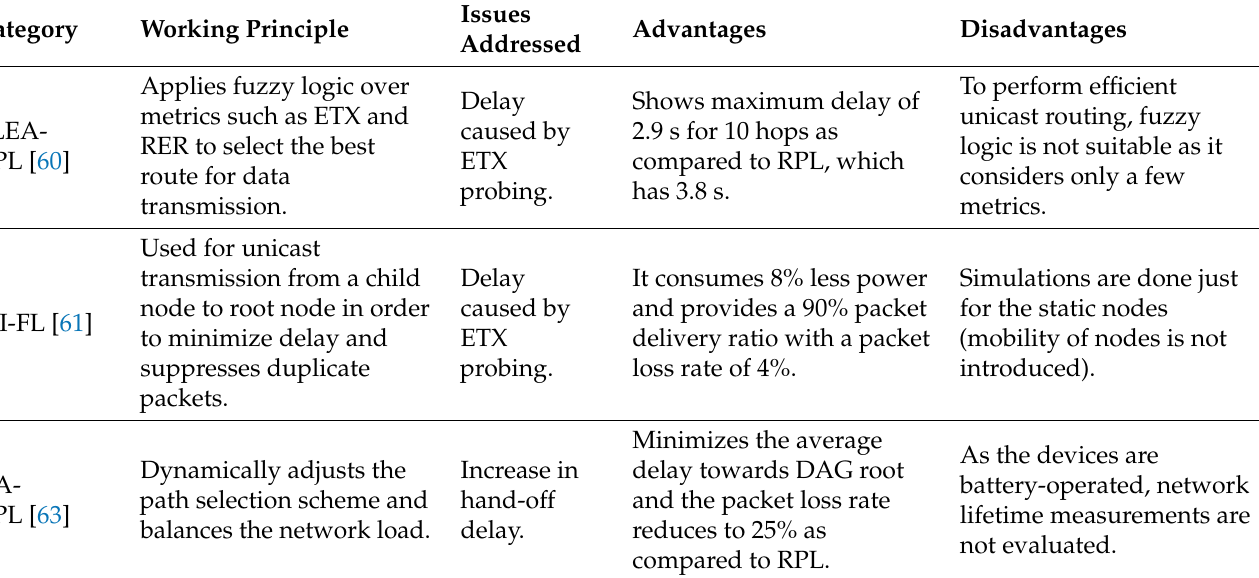
Table 2. Summary of ETX-based